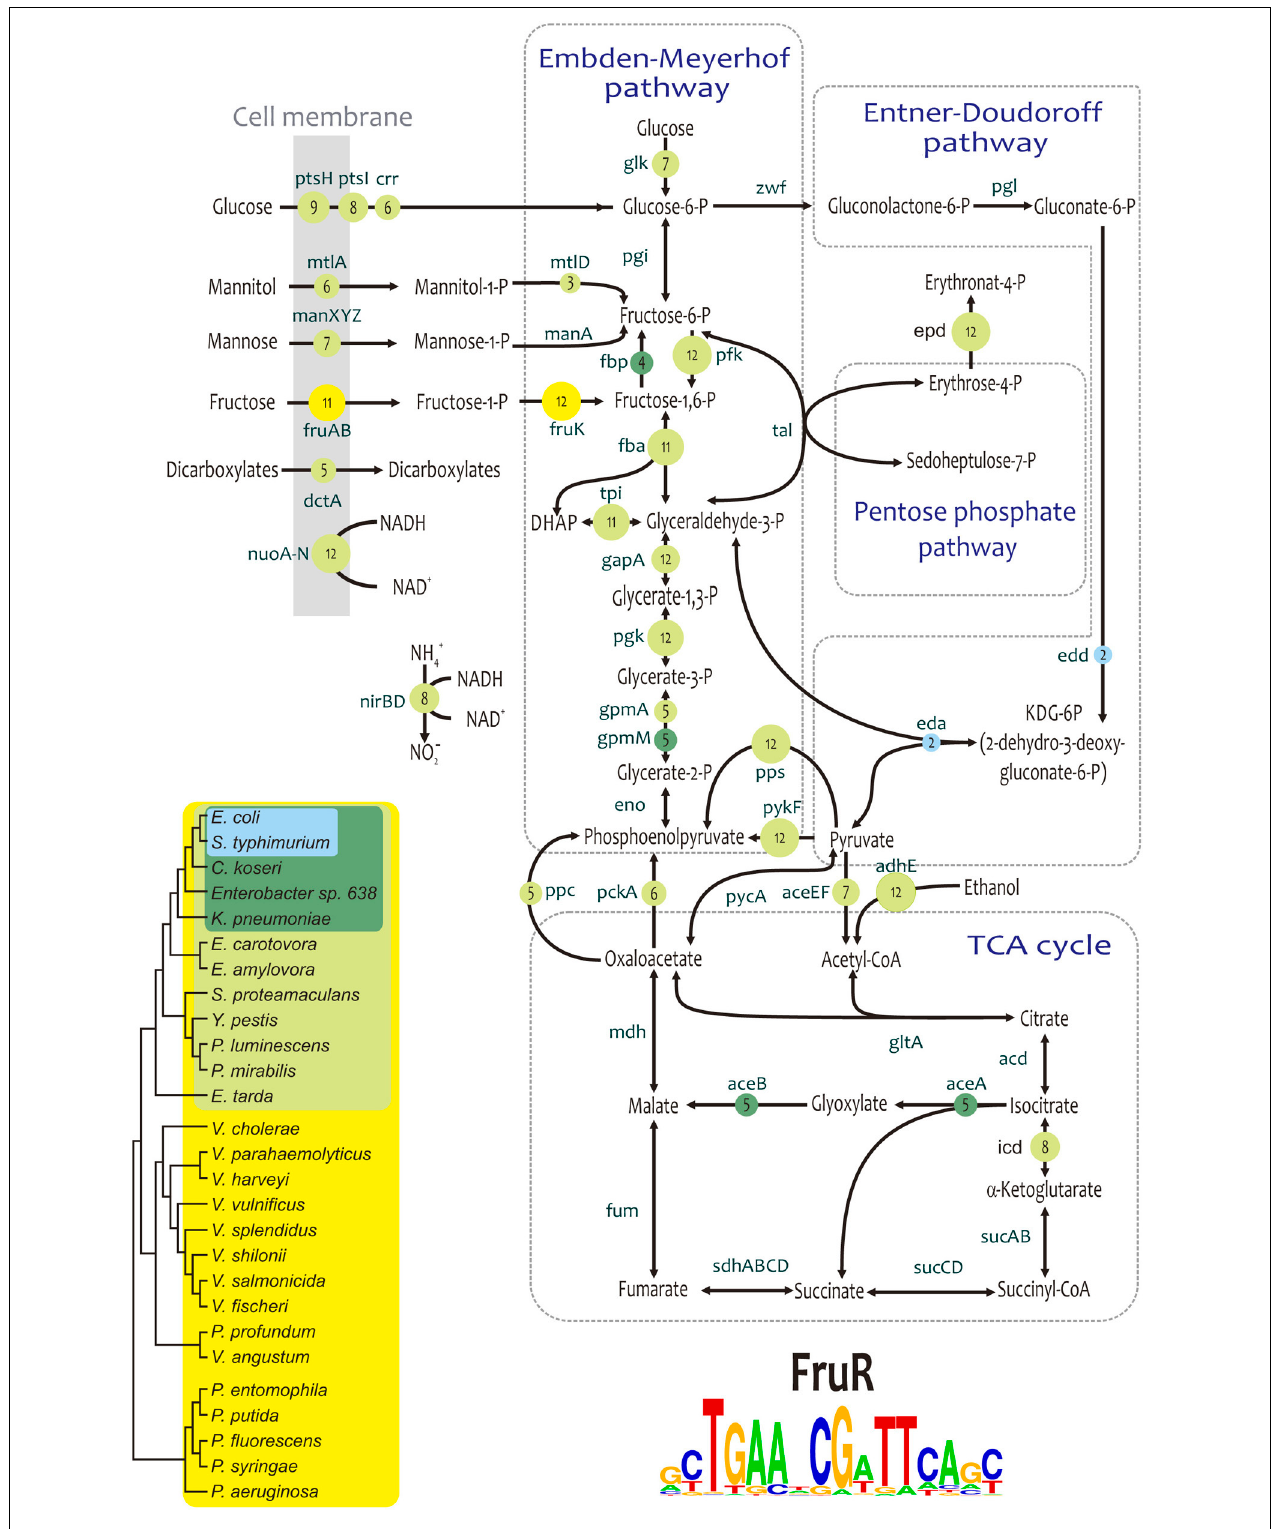
FIGURE 6 | Content of reconstructed FruR regulons in Gammaproteobacteria. Names of regulated genes and operons are shown at arrows. Numbers in circles show the numbers of genomes with correspondent regulation.